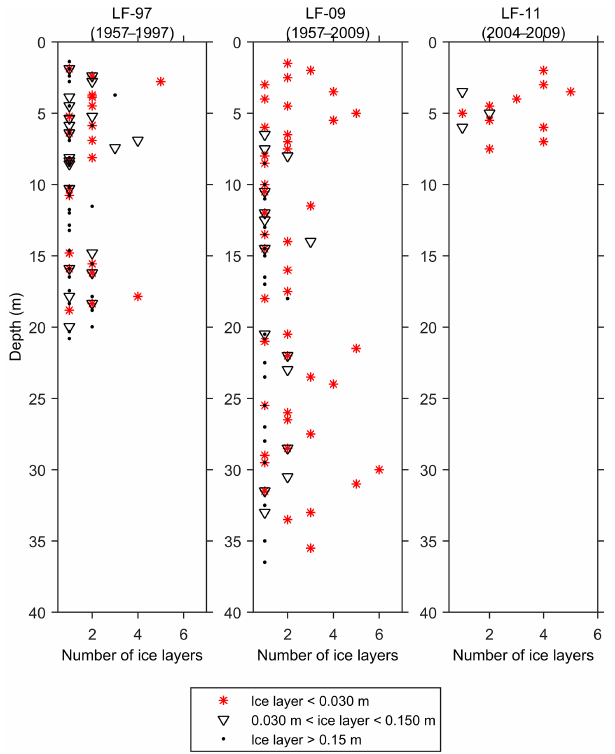
Figure 9. Number of ice layers found at different depths in the: LF- 97 (left), LF-09 (centre) and LF-11 (right) ice cores. The ice layers were divided in three classes according to their thickness: thin layers ( ∗ ), medium-thick layers ( ∇ ) and thick layers ( • ).